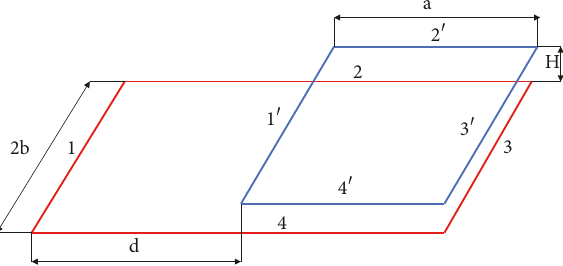
Figure 13: Disposition of two parallel loops of different